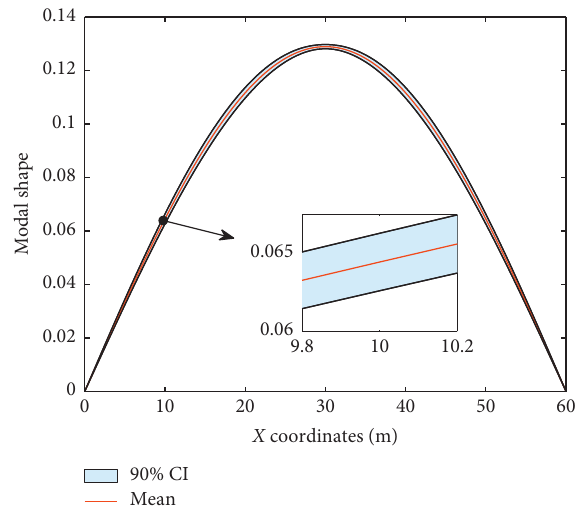
Figure 6: First-order mode shape with only the deflection com- ponents. The red line represents the mean of 10,000 MCSs, and the band represents 90%